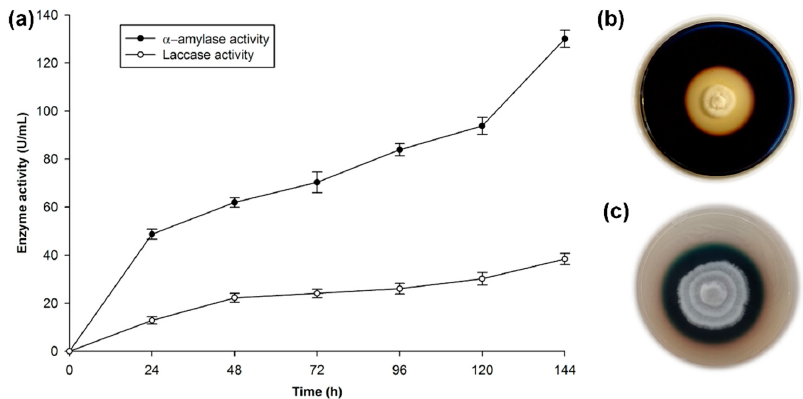
Figure 1. Test of the enzyme activity of the Trametes hirsuta Bm-2 strain. ( a ) Quantitative activity of laccase and α -amylase enzymes, ( b ) screening for amylolitic activity in plates incubated at 32 °C for 144 h, ( c ) screening for laccase activity in plates incubated at 32 °C for 96 h. The results are represented as the mean ± standard deviation of three parallel measurements ( n = 3).